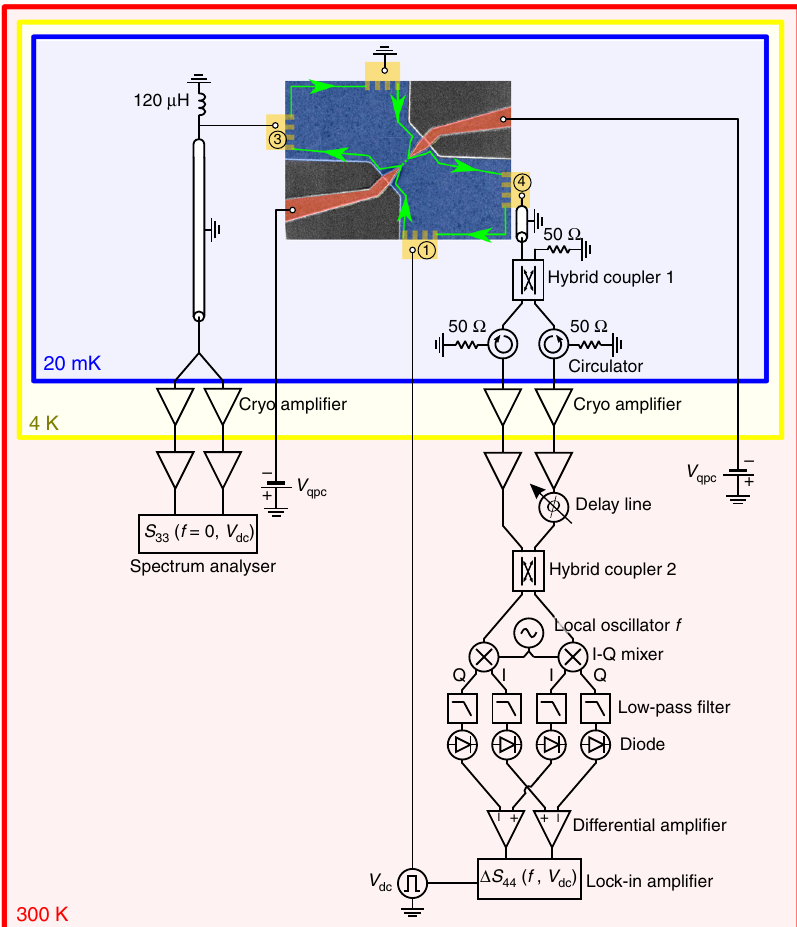
Fig. 1 Experimental setup. The low frequency shot noise is measured at output 3 of the sample and high frequency one at output 4. A square pulse drive V dc ( t ) modulates the applied voltage on input between 0 and the variable amplitude V dc at frequency 234 Hz for lock-in detection of the high frequency noise (see Methods). The microwave noise emitted by the sample is split, ampli fi ed and recombined 31 at the output 0 of hybrid coupler 2. The noise power on the I and Q quadratures at the measurement frequency f are measured using I/Q mixers followed by diodes in a 1.5 GHz bandwidth de fi ned by low pass fi lters. Low frequency differential ampli fi ers measure the power difference between the two outputs of hybrid coupler 2 in order to subtract the ampli fi er noise (see Methods). The emitted noise on the I and Q quadratures are then measured using lock-in detection at the modulation frequency 234 Hz and averaged together as the emitted noise is the same for the two quadratures